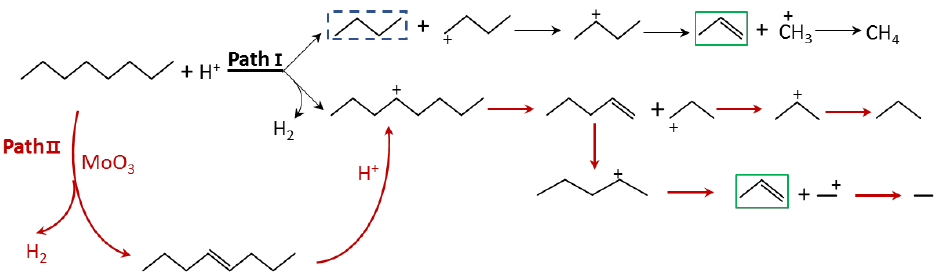
Figure 4. The schematic diagram for the proposed reaction pathways of n -octane over cracking catalyst (Path Ⅰ ), dehydrogenation, and cracking catalysts (Path Ⅱ ).